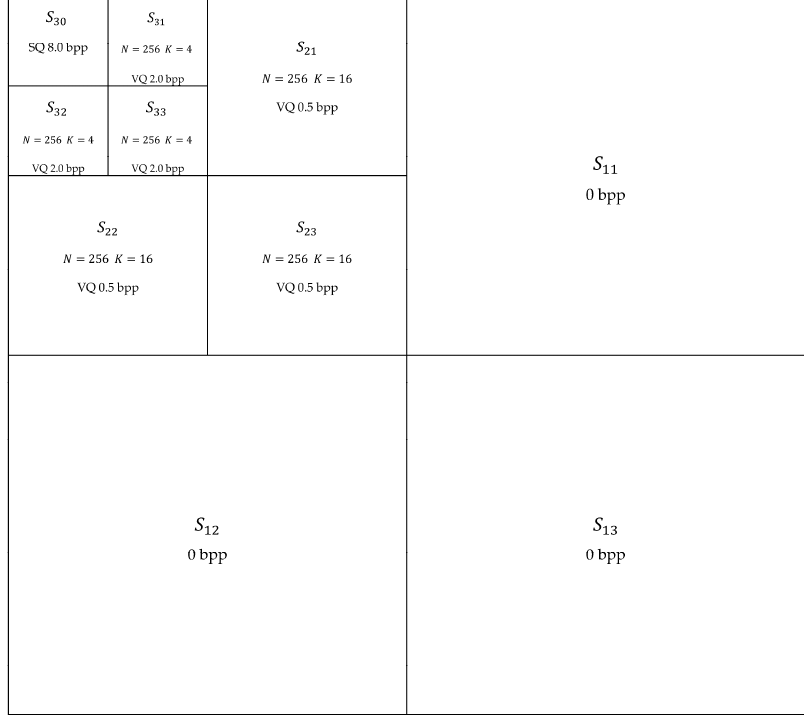
Figure 2. Image encoding using DWT.